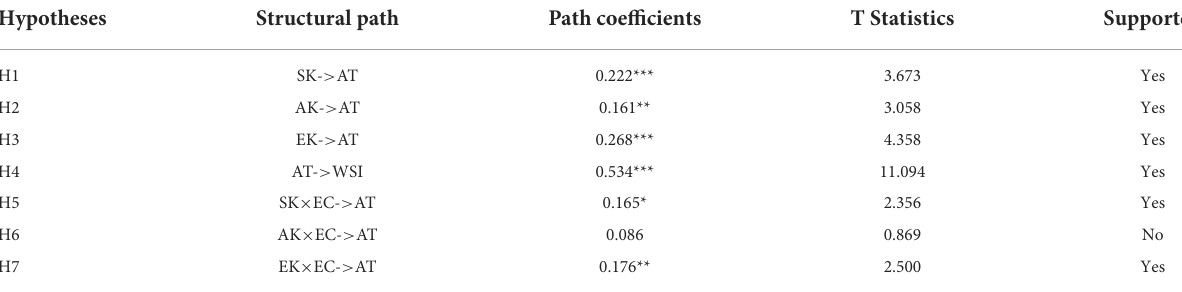
TABLE 4 Hypotheses testing results.